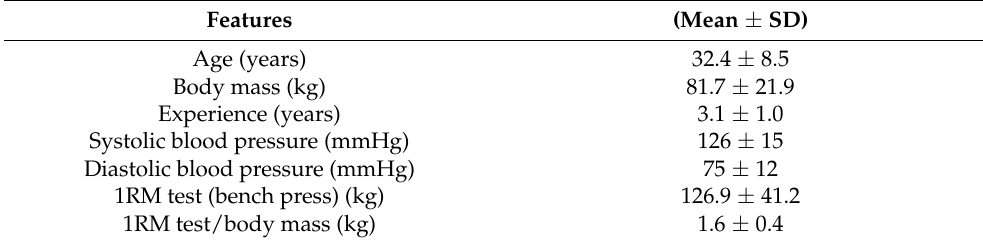
Table 1. Characteristics of the study participants n =